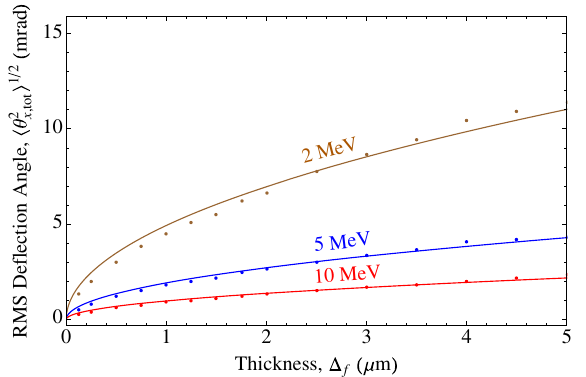
FIG. 3. Dots give smoothed (large angle events rejected) rms ¼ 3000 deflection angle computed with SRIM, averaged over N P protons with initial ion kinetic energy E after penetration of a b solid aluminum foil of thickness Δ . Solid lines correspond to fits f of the data based on Eq. (6) using a least-squared method for each initial kinetic energy E . Brown, blue, and red colors respectively b ¼ 2 , 5, and 10 MeV. represent the initial kinetic energies of E b